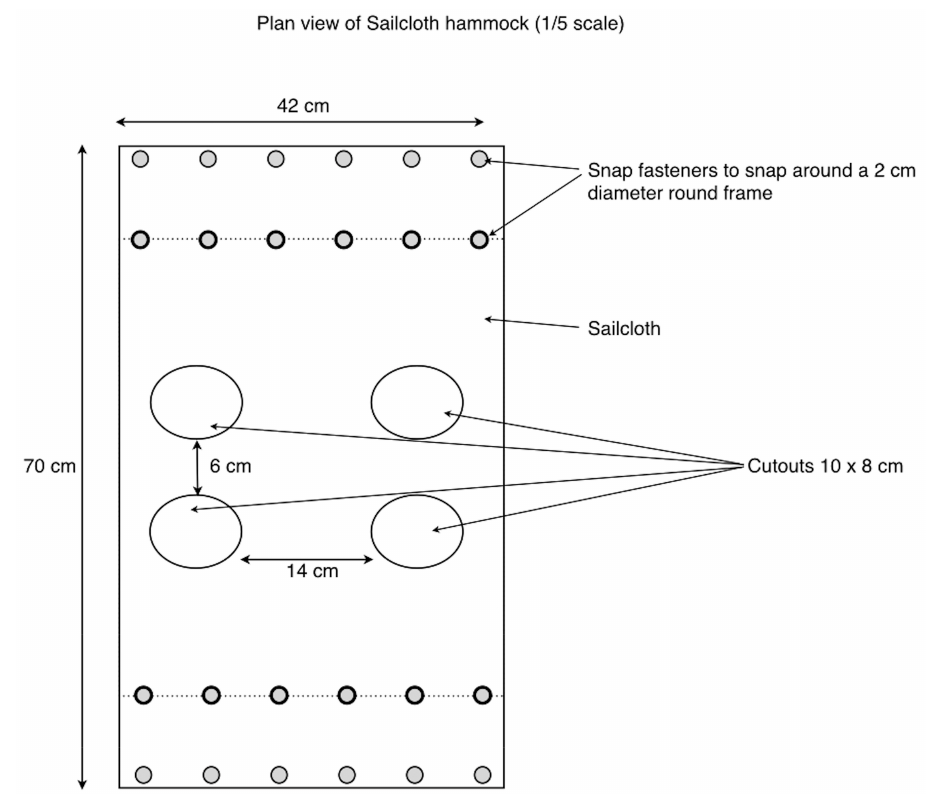
Figure 3. Sailcloth hammock